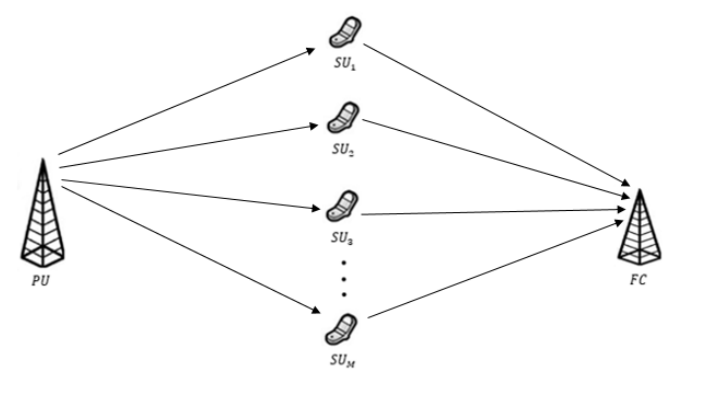
Figure 1. Illustration of a cognitive radio